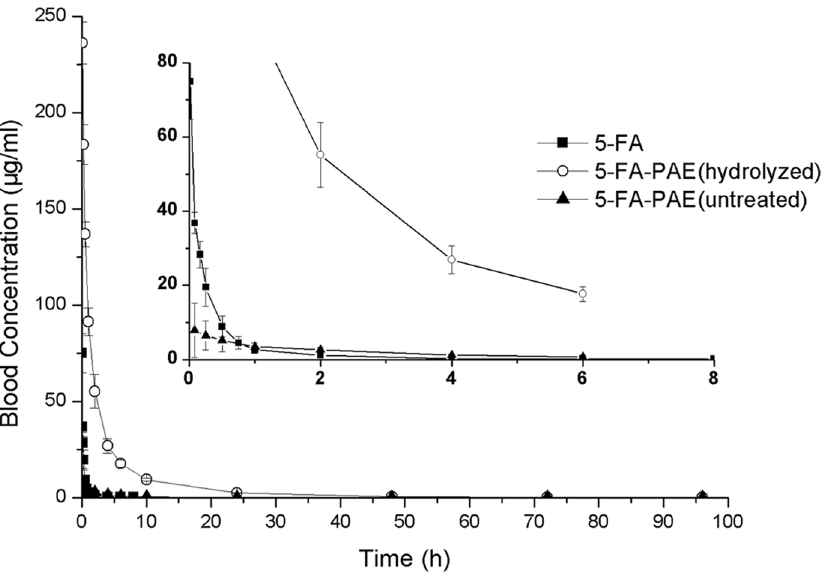
Figure 3. Pharmacokinetics of 5-FA and 5-FA-PAE after i.v. injection. The control group and the test groups were administered intravenously with 20 mg/kg of 5-FA or 189 mg/kg of 5-FA-PAE (equivalent to 20 mg/kg of 5-FA) dissolved in physiological saline, respectively. Each plasma sample of the 5-FA-PAE group was divided into two portions (treated as hydrolyzed and unhydrolyzed), which were analyzed by HPLC to determine the plasma concentrations of released 5-FA and total 5-FA of the conjugate whereas the plasma samples of the control group were treated as unhydrolyzed samples. Each value represents the mean 6 standard deviation (n=6).